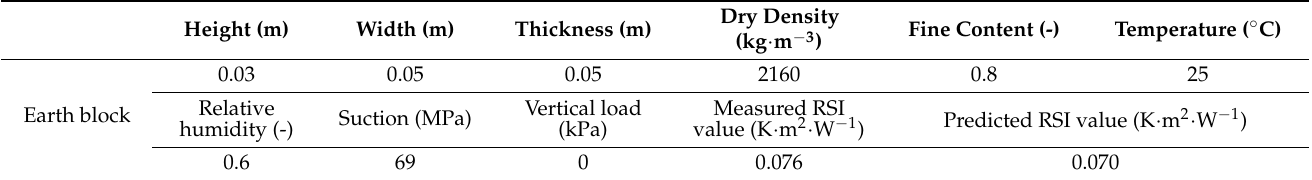
Table 3. Comparison of the measured and predicted RSI